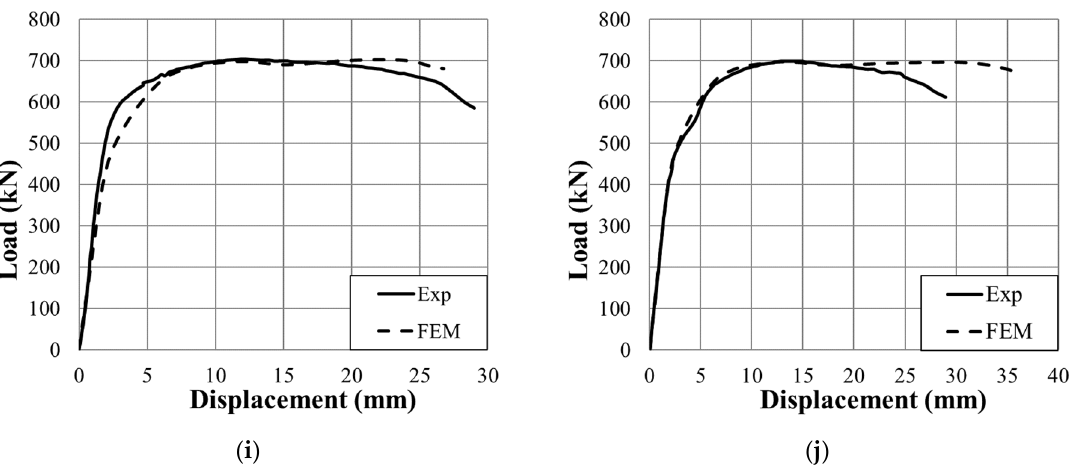
Figure 11. Load–displacement response for the circular specimens from the experiment and the finite element model.